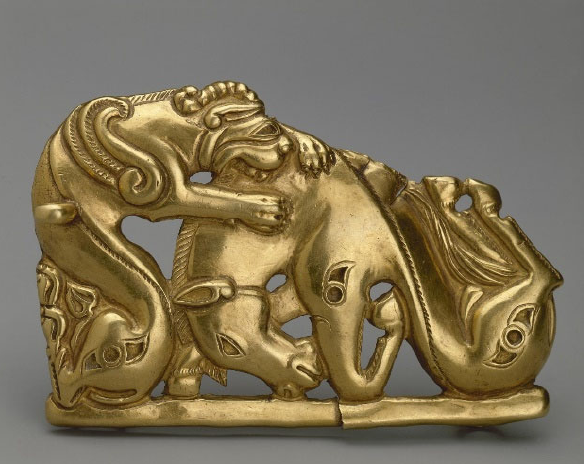
Figure 32. Belt plaque (left) with scene of animal combat (SHM inv. no. C и .1727-1/6); cast and chased gold; Siberian Collection of Peter I; c. 4th to 3rd century BC. [Image is used from www.hermitagemuseum.org (accessed 9 November 2022), courtesy of the State Hermitage Museum, St. Petersburg,